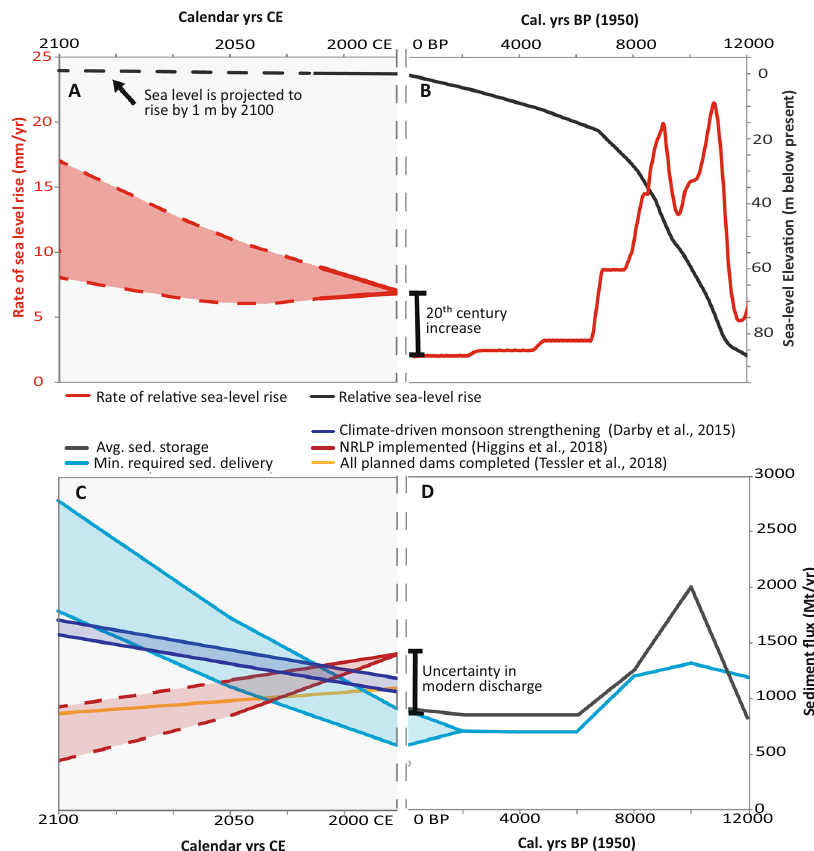
Fig. 4 | Holocene and predicted future changes in sea level and sediment delivery to the Ganges – Brahmaputra. A Comparison of future changes in sea level(shownrelativeto1992CE) 133 to B Holocenechangesinglobalsealevel(shown relativetoEGM96) 126 .Localsealevel(notshown) 134 andrelativesealevelisexpected toriseby~1mby2100(blueline, A ). C Inthefuture,predictedchangesinmonsoon strength 135 and river damming with the National River Linking Project (NRLP) 33,40 indicate that sediment fl uxes reaching the delta may increase or be